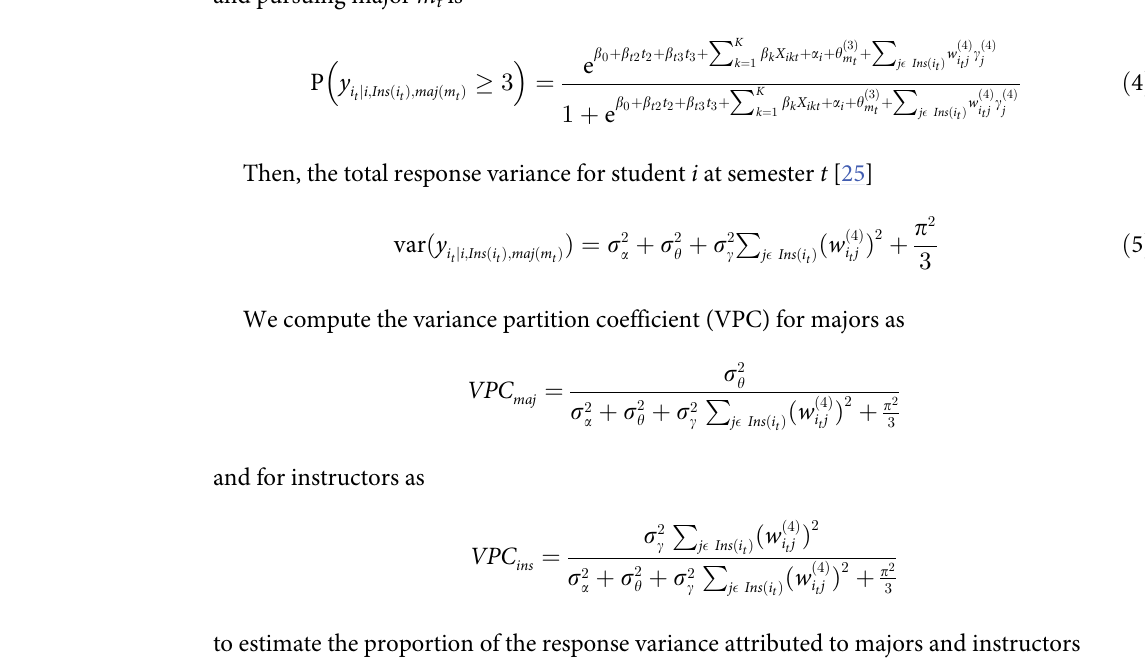
PLOS ONE | https://doi.org/10.1371/journal.pone.0227343 January 30,